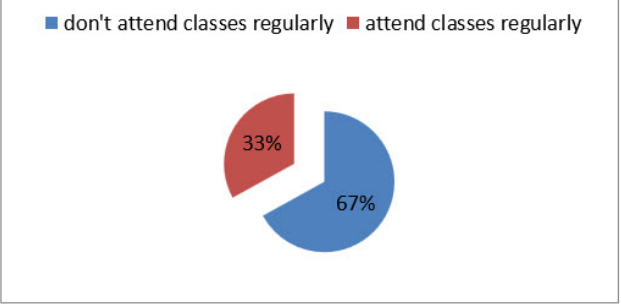
Figure 1. Attendance of Roma pupils in the first cycle of primary